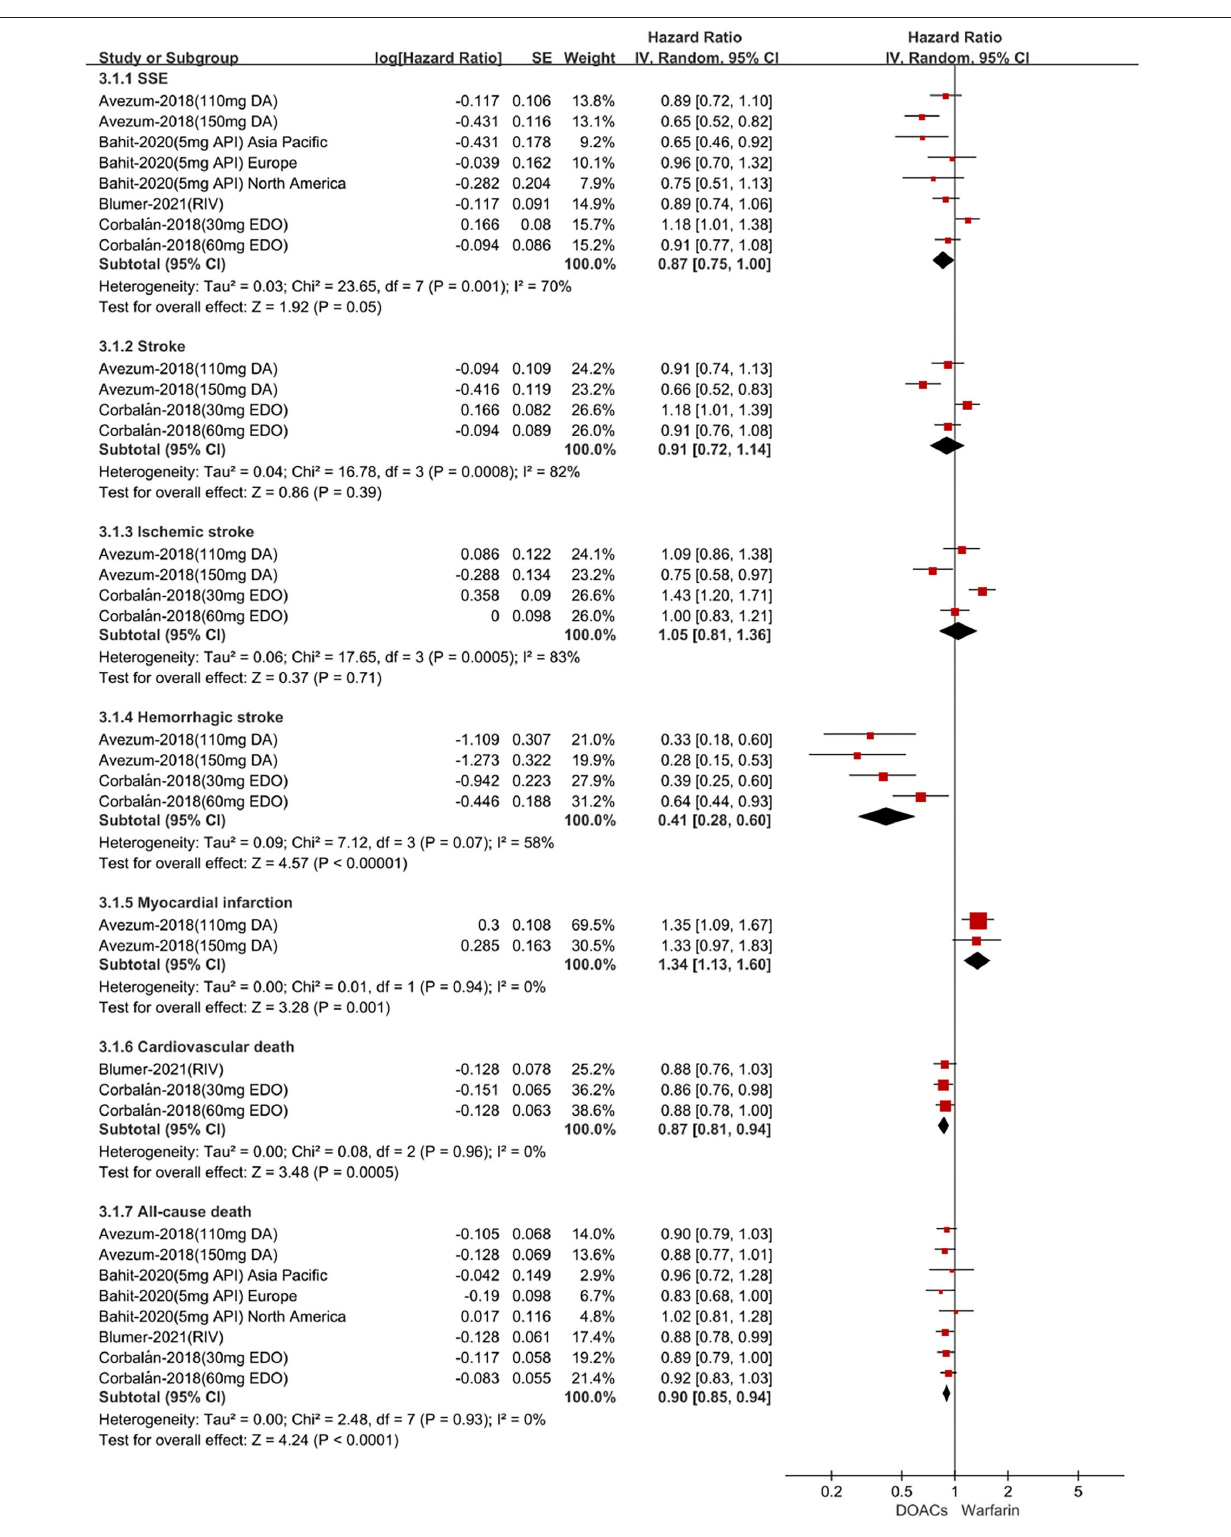
Frontiers in Cardiovascular Medicine |